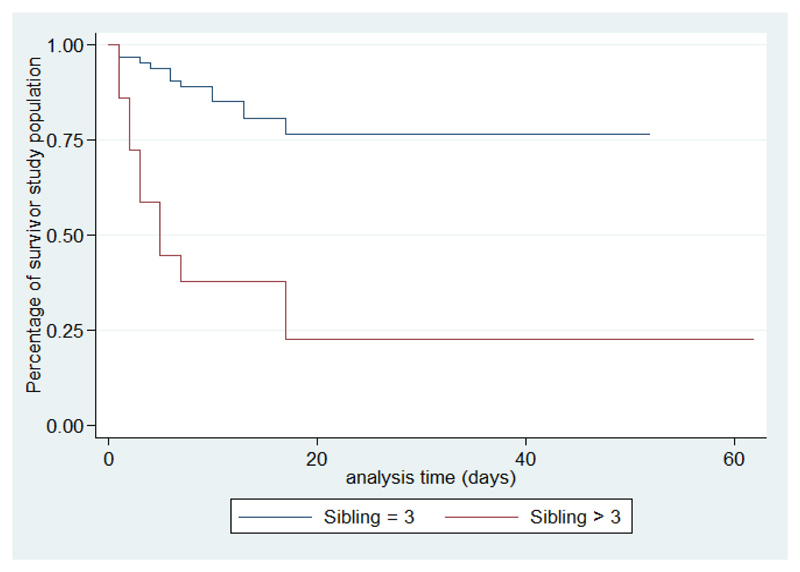
Survival analysis curves according to sibling